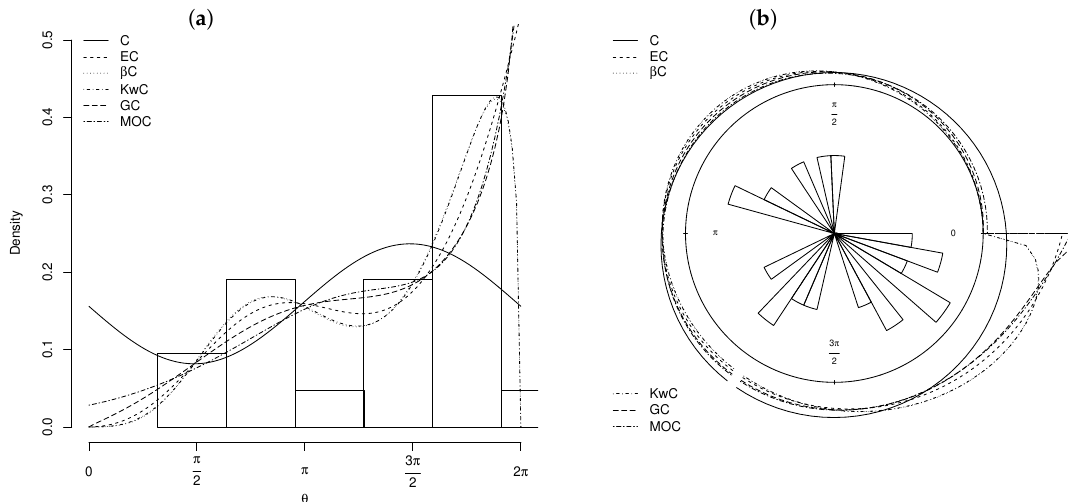
Figure 6. Fitted densities of the C, EC, β C, KwC, Γ C, and MOC models to the first dataset. ( a ) histogram and ( b ) rose diagram.